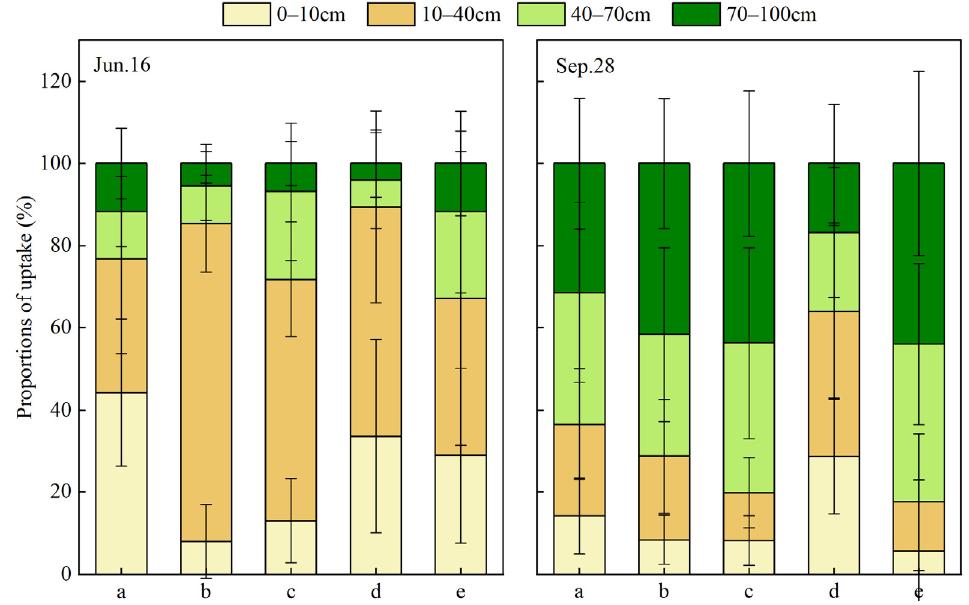
Figure 9. Seasonal variations in fraction of water uptake from different soil layers based on MixSIAR for (a) P. massoniana , (b) C. lanceolata , (c) Q. acutissima , (d) I. corallina and (e) C. funebris.